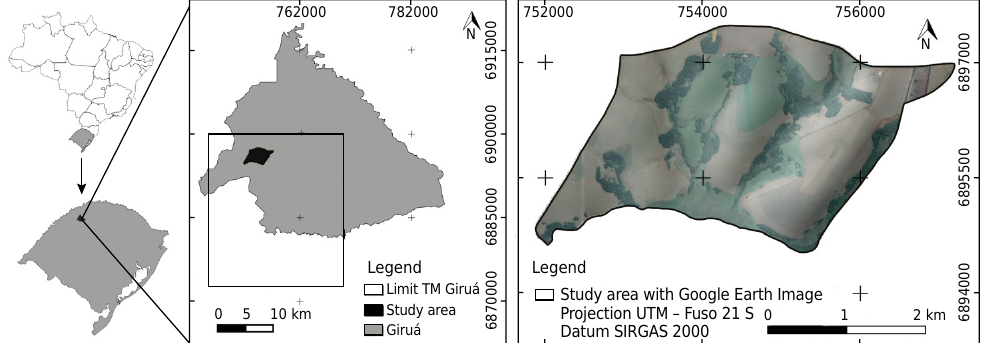
Figure 1. Location of the study area in the municipality of Giruá, Rio Grande do Sul state, Brazil, limit indication of Giruá Topographic Map (TM) and expanded study area with the Google Earth